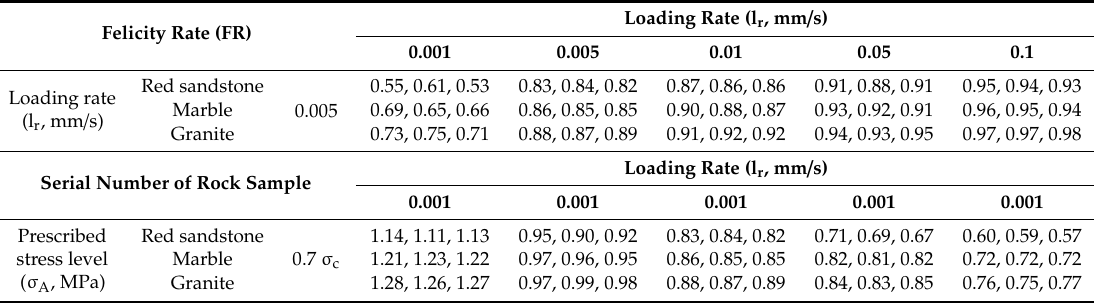
Table 2. Felicity rate values under different stress levels and loading rates.